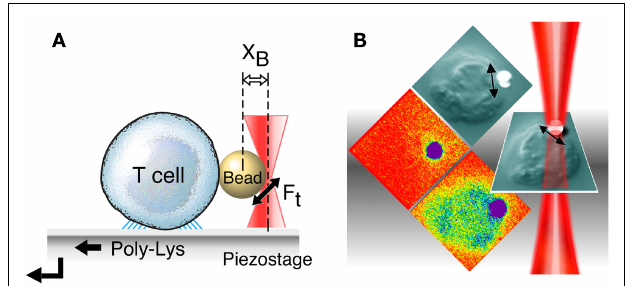
FIGURE 2 |T cell activation using optical tweezers. (A) Mechanical force application using optical tweezers. AT cell is immobilized on poly L-Lysine coated cover glass. After a trapped ligand-coated polystyrene bead is guided into contact with a surface-boundT cell using an automated piezoelectric stage, a continuous sinusoidal tangential force is applied to the bead by moving the trapping laser back and forth (X B , distance from the trap center to the bead center; Ft, applied force by optical trapping laser). (B) Calcium flux inT cells after application of external mechanical force using optical tweezers. Optical tweezers are employed for application of force (double headed arrow) to a polystyrene bead (white) arrayed with specificT cell receptor ligand (pMHC, in this caseVSV8/K b ).The bead abutting the surface of a singleT cell (naïve N15TCR transgenicT lymphocyte) is shown in the DIC image as gray.The tangential force (50pN) along theT cell surface triggers a rise in intracellular calcium flux shown in colorization through an increase in green intensity (bottom panel).Without force application, the bound ligand induces no increase in calcium (middle panel).